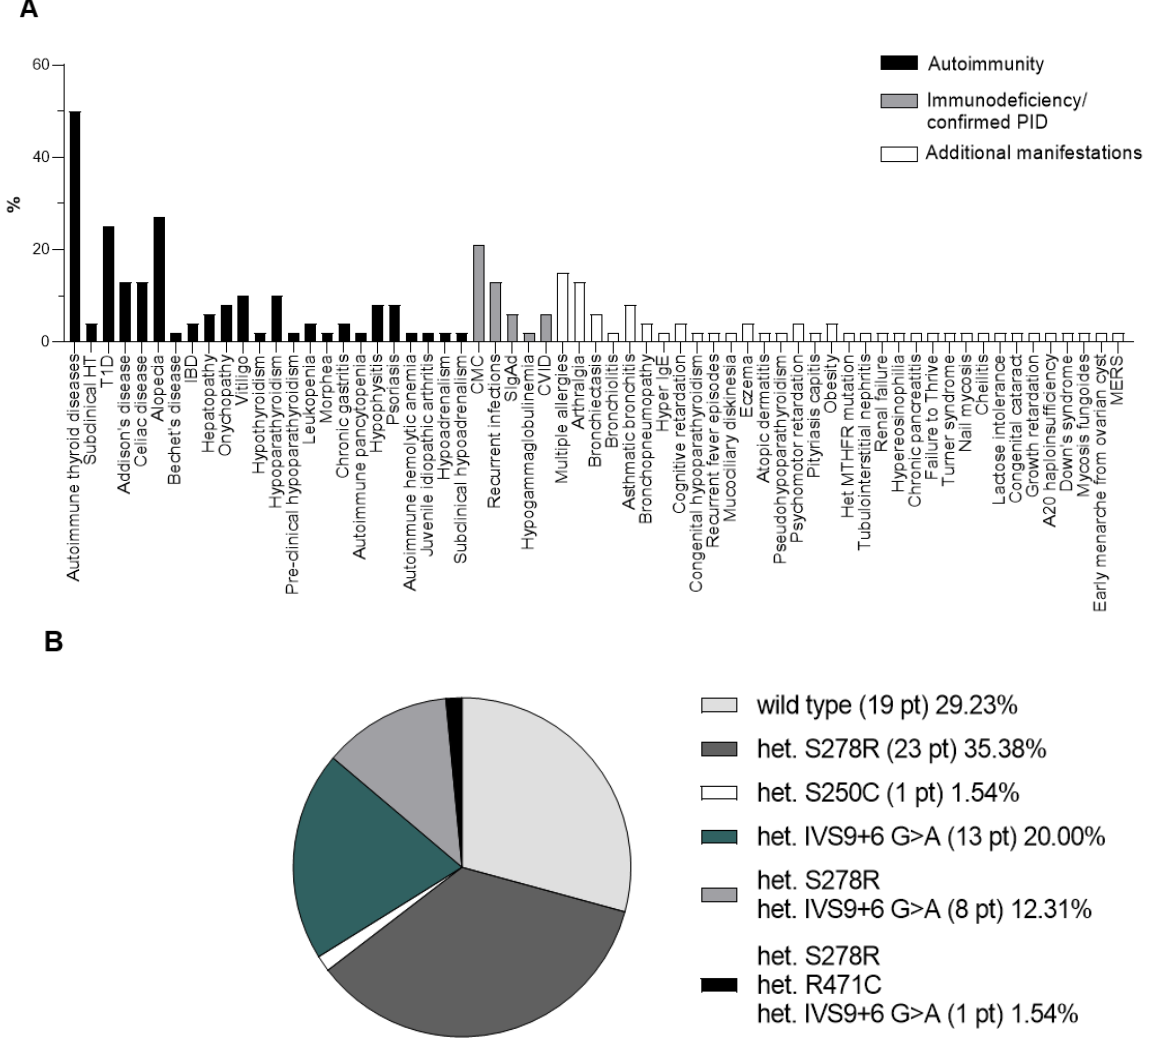
Figure 1. ( A ) Prevalence (%) of clinical manifestations and ( B ) prevalence of S278R, IVS9+6 G>A polymorphism, R471C mutation and S250C variant in the APECED-like patients.